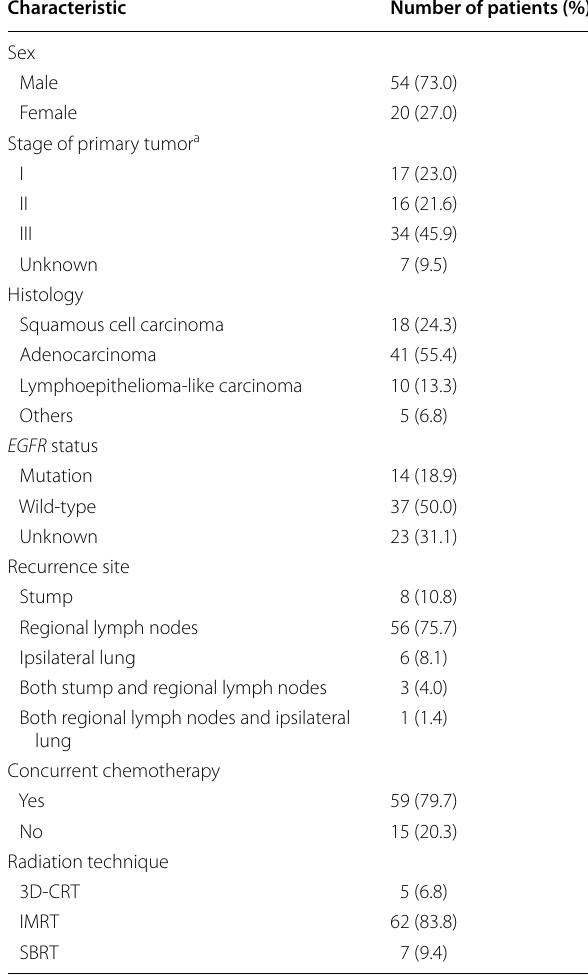
Table 1 Characteristics of 74 NSCLC patients with postop- erative locoregional recurrence treated with radical radio-